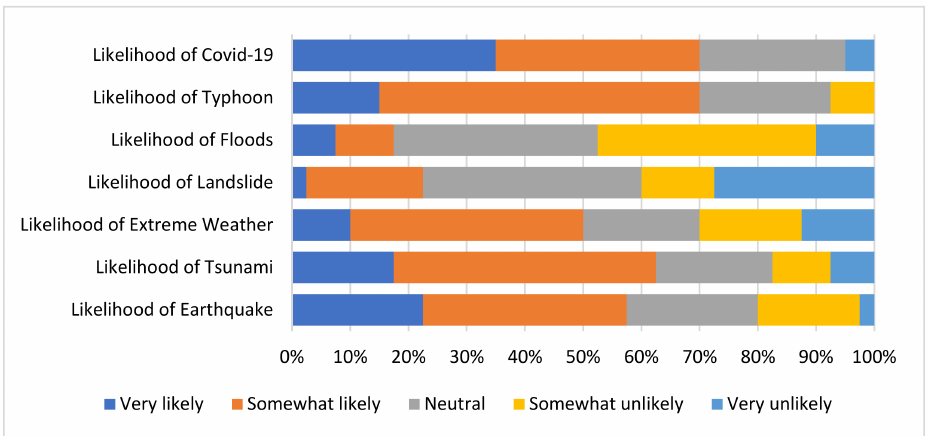
Figure 5. Perspective of the likelihood of